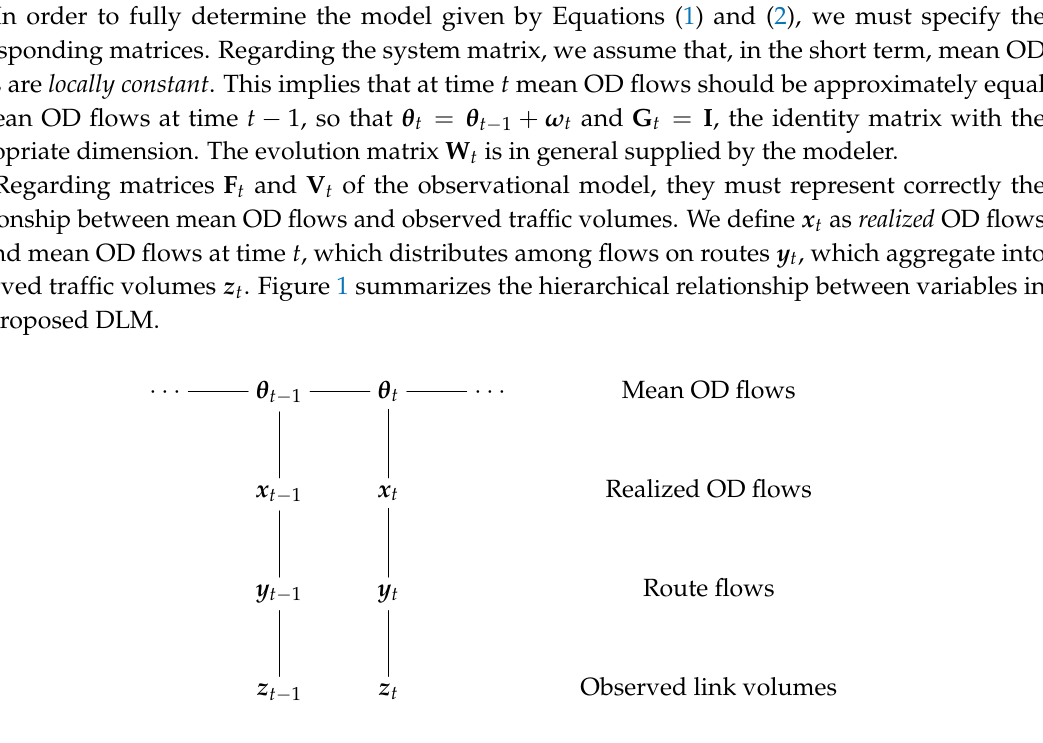
Figure 1. Hierarchical relationship between variables in the DLM. Mean OD flows, realized OD flows and route flows are unobserved